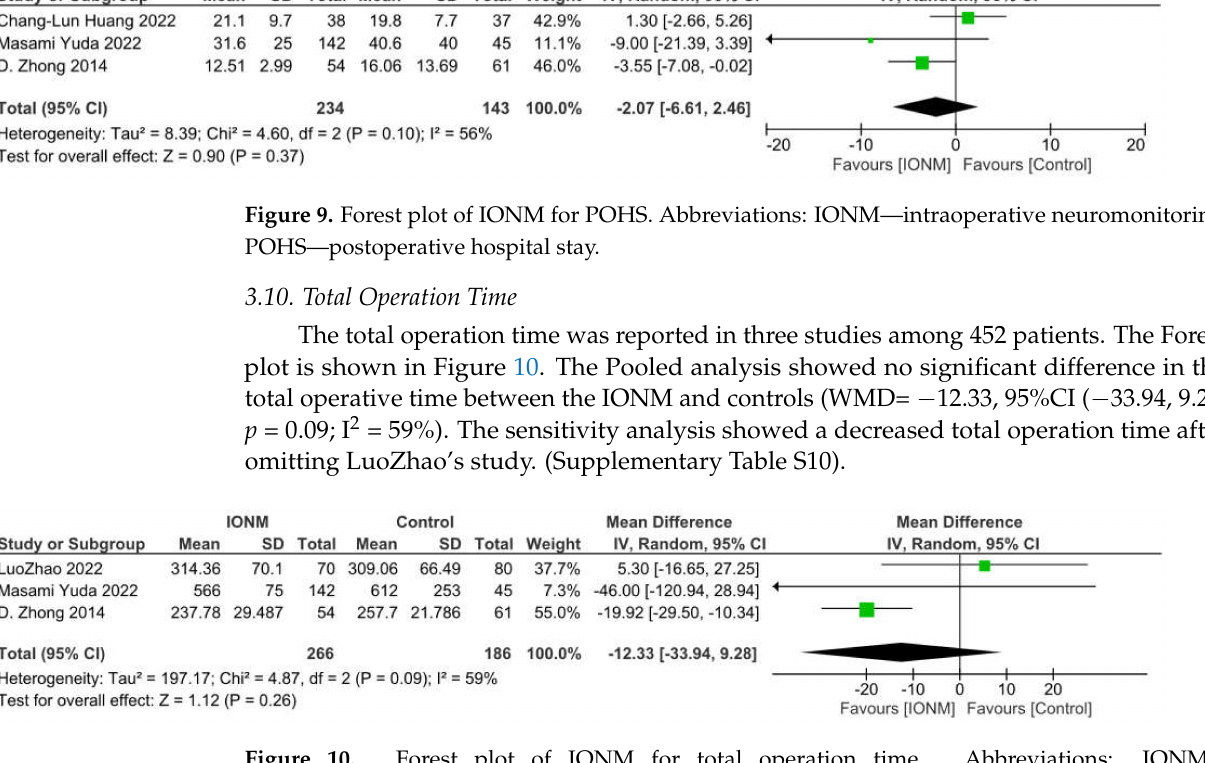
Figure 10. Forest plot of IONM for total operation time. Abbreviations: IONM— intraoperative